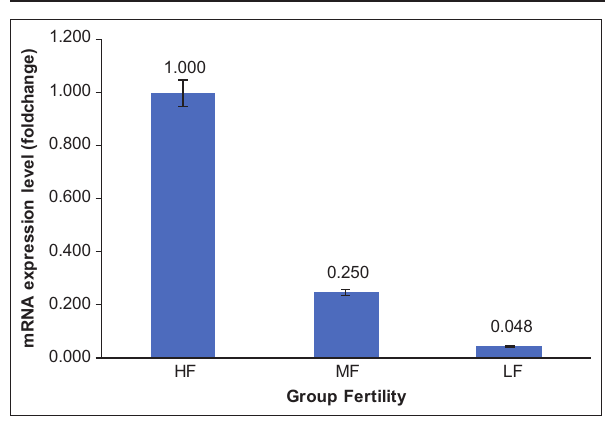
Figure-5: Heat shock protein 70-2 mRNA expression levels in bovine sperm collected from Madura bulls with high fertile, medium fertile, and low fertile quality sperm. Significant differences (p < 0.05) [Source: Rosyada et al. , unpublished